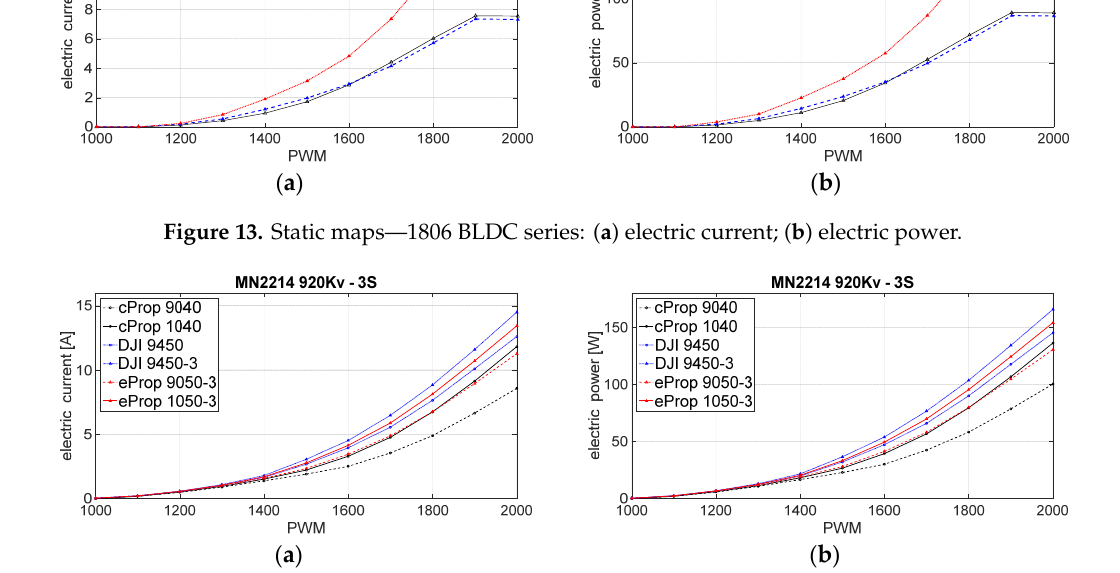
( b ) Figure 15. Static maps—MN 4014 BLDC motor: ( a ) electric current; ( b ) electric power. 4. Electric Propulsion System Characterization The characterization of EPU can be performed in several ways [26,27]. In this research, the characterization was performed based on the obtained three series of static maps. The characterization is necessary for the proper selection of propulsion components, further analysis of the electric propulsion system, and could be a starting point for propulsion system parameters optimization. The characterization procedure can be divided into two parts wherein the first mechanical quantities are considered in the form of aerodynamic forces and moments with respect to the angular velocity of the rotor, and in the second electrical quantities, i.e., electricity consumption. 4.1. Aerodynamic Forces and Moments The aerodynamic forces and moments (thrust force and drag torque), according to equations 15 and 17, directly depend on the rotor angular velocity. Based on the obtained curves (Figures 16–18), it was possible to estimate the factors of aerodynamic forces in the EPU working area for the purposes of conducting computer simulations of the multirotor UAV behavior. The factors can be further investigated through the thrust coefficients and motor power coefficients according to equations 16 and 18. Figures 16–18 show thrust forces and drag torques as a function of rotor angular velocity for